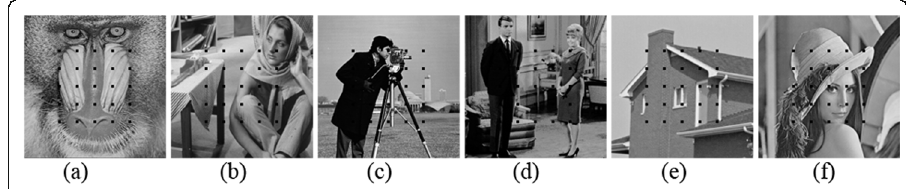
Fig. 7 Six images damaged by